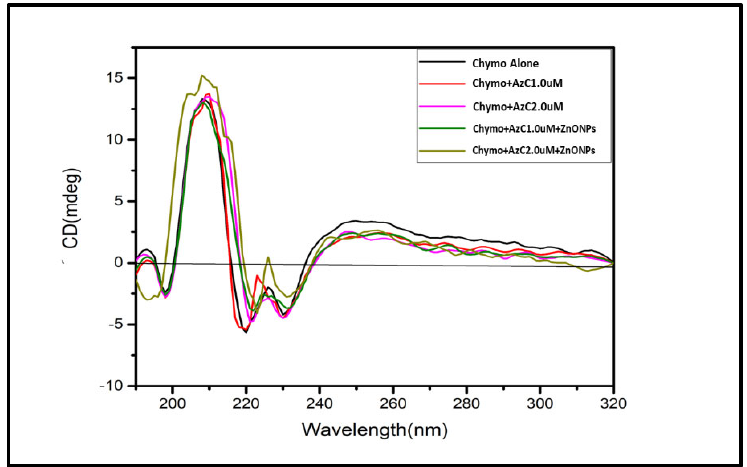
Figure 6. CD spectra of Chymo in the presence of AzC and AzC ‐ ZnONPs